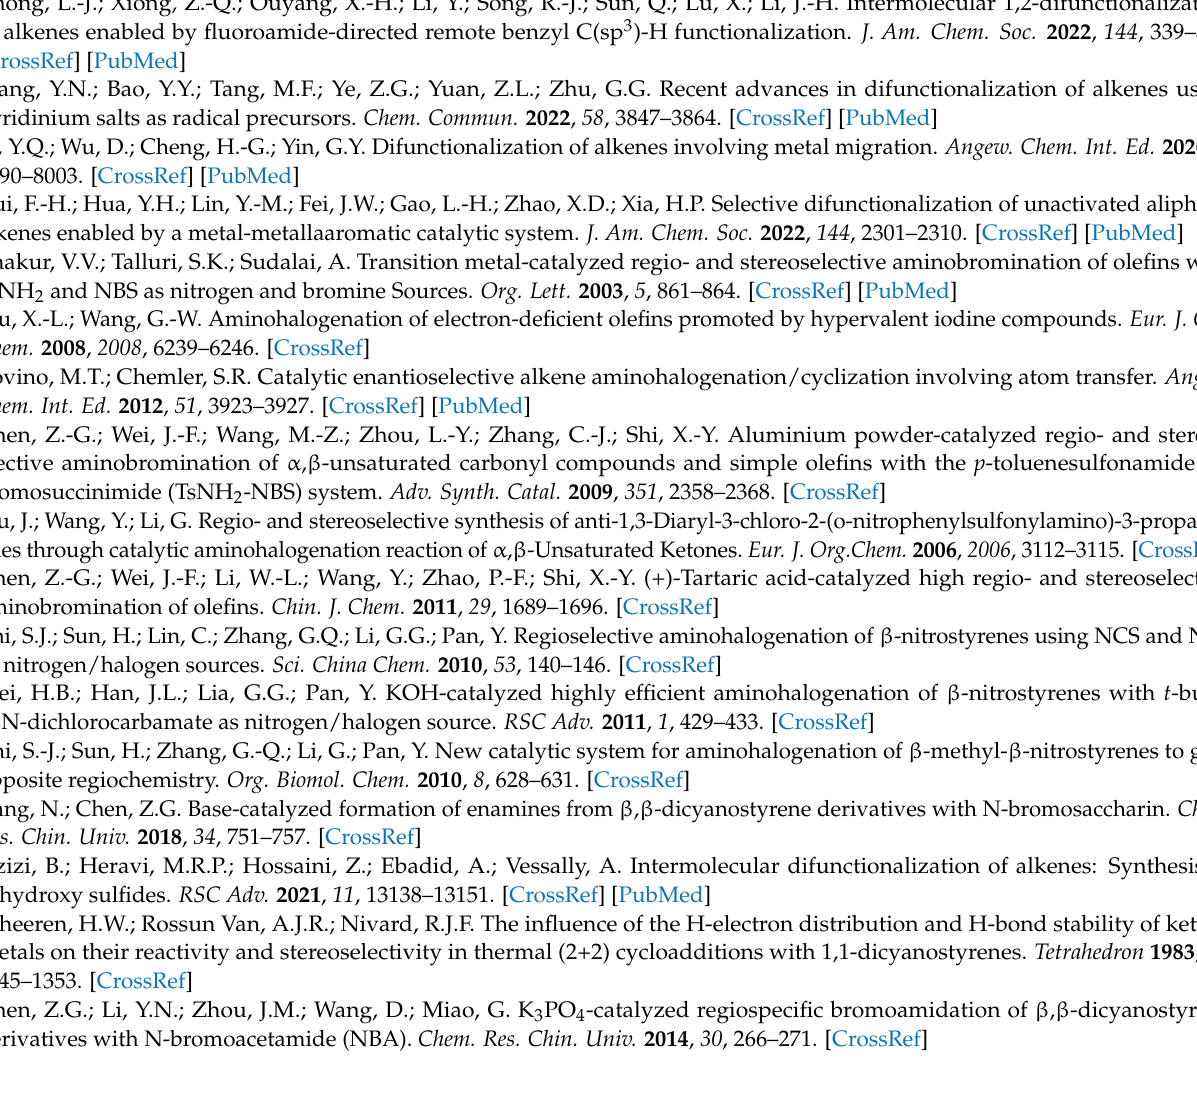
Table S1. condition optimization. Figure S1. H-NMR and 13C-NMR spectra of compound 1 . Figure S2. 1H NMR and 13C NMR spectra of compound 2